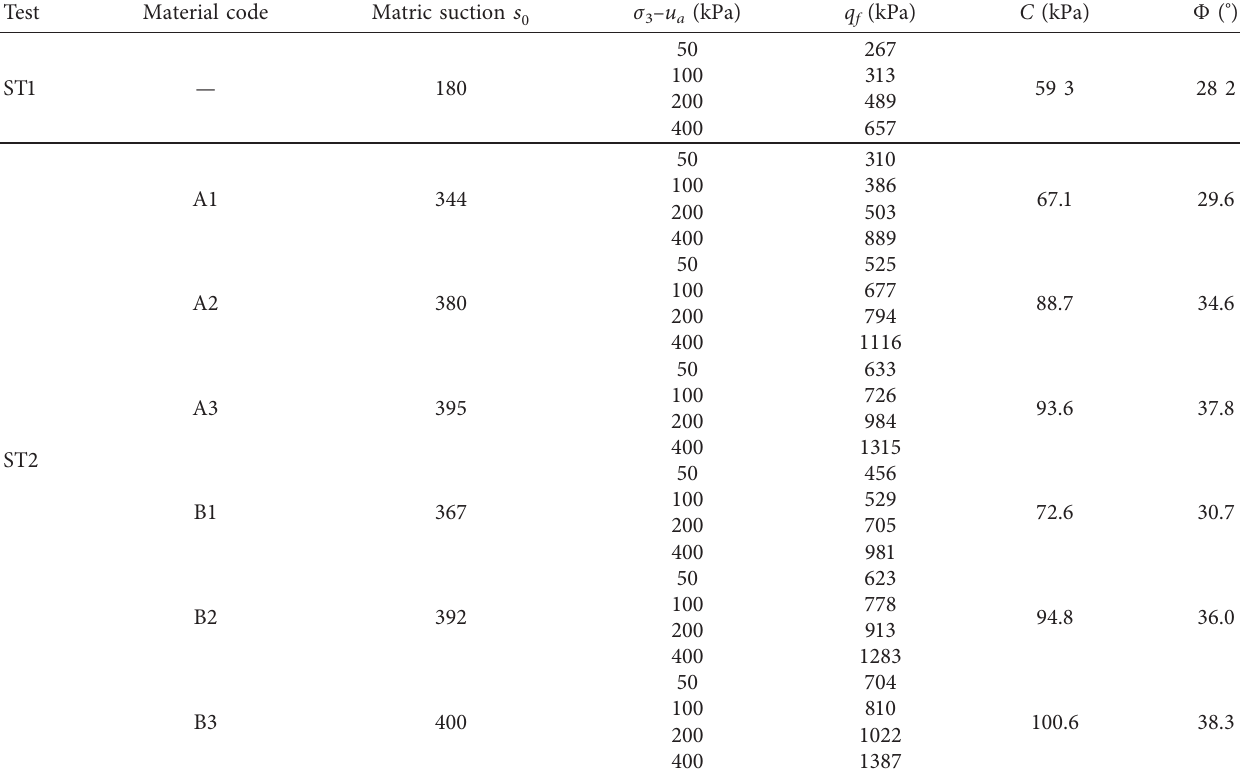
Table 3: Testing results of the ST tests.